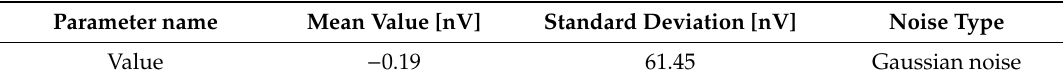
Table 3. The parameters setting of the noise.